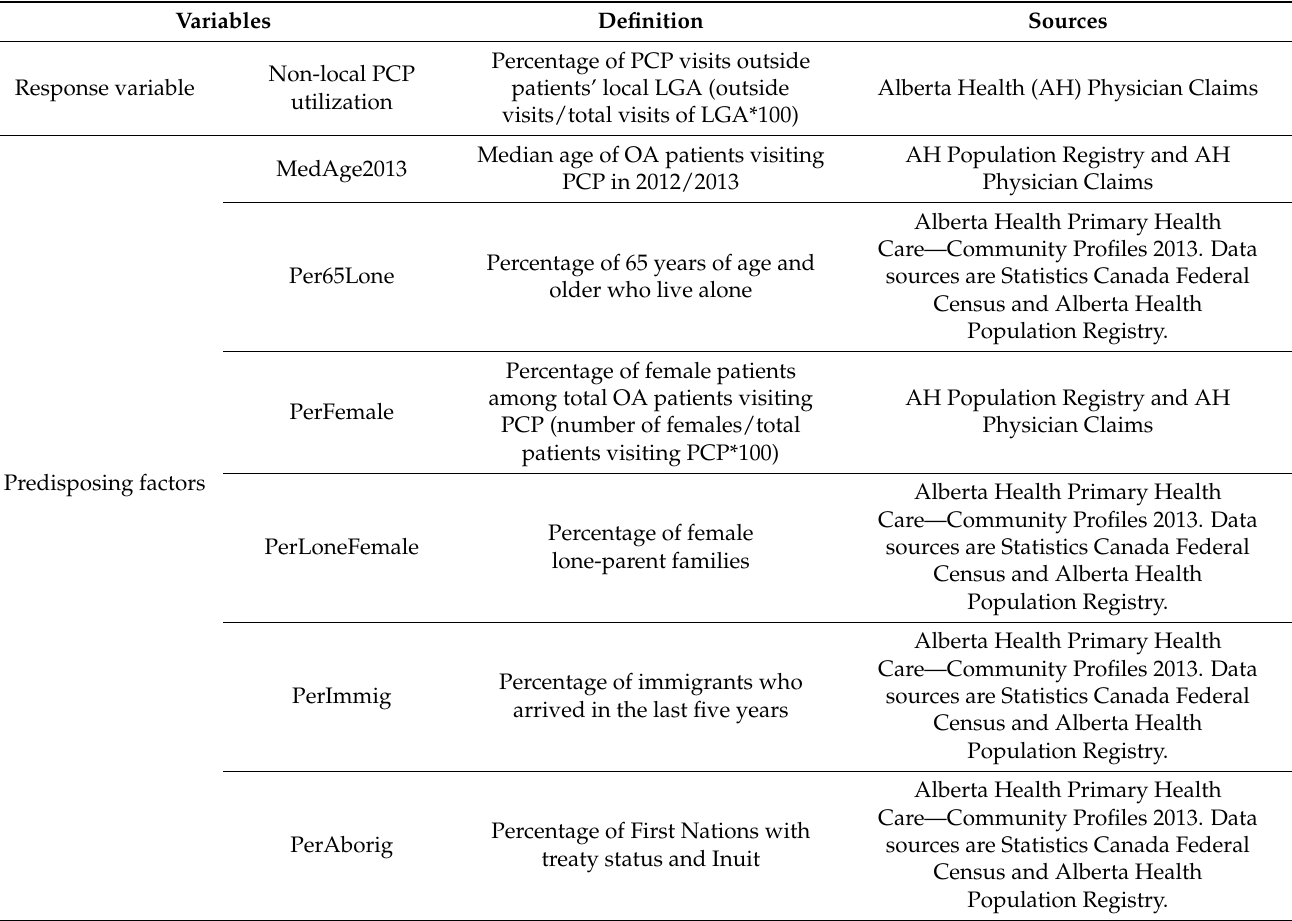
Table 1. List of response and predictor variables at LGA